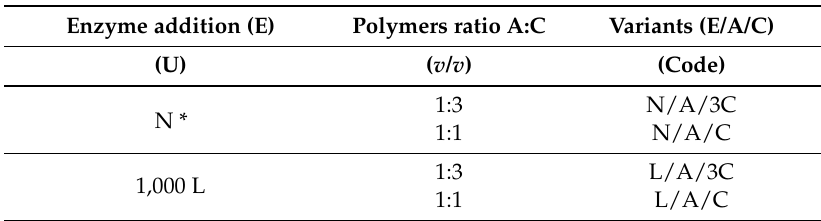
Table 1. Enzyme/alginate/chitosan hydrosols